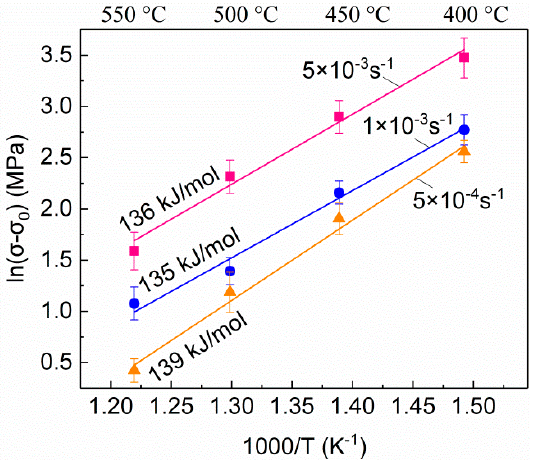
Figure 6. Logarithmic stress as a function of reciprocal temperatures and the apparent activation energy Q of the fine-grained 5A70